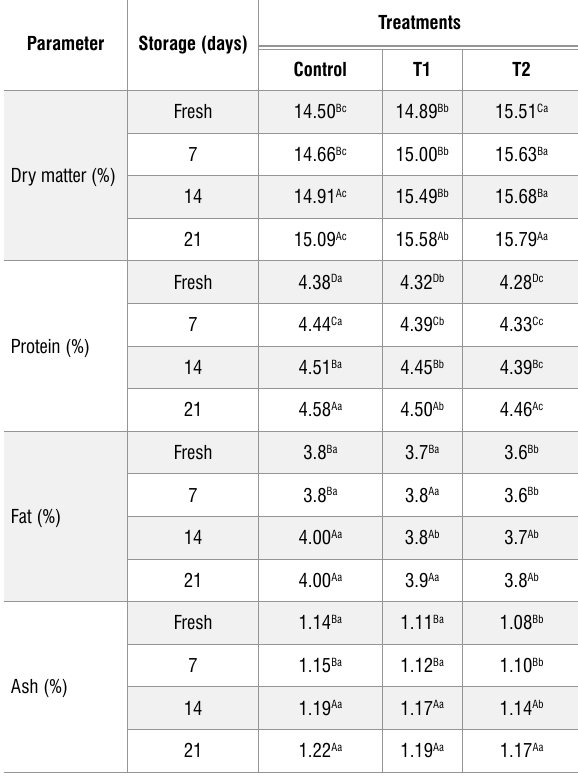
Data are expressed as a mean of three replicates. Means with the same uppercase letter superscripts indicate insignificant difference ( p ˃ 0.05) between columns, and means with the same lowercase letter superscripts indicate insignificant difference between rows ( p ˃